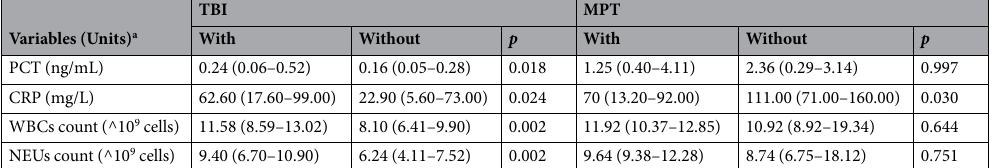
Table 4. Comparison of Inflammatory Markers in Patients with TBI or MPT. p , differences between subgroups with or without acute lung injury (ALI) as determined by nonparametric Mann-Whitney U tests. Continuous variables are expressed as medians (IQRs). CRP, C-reactive protein; MPT, multiple peripheral trauma; NEUs, neutrophils; PCT, procalcitonin; TBI, traumatic brain injury; WBCs, white blood cells. a Represents the mean values at different time